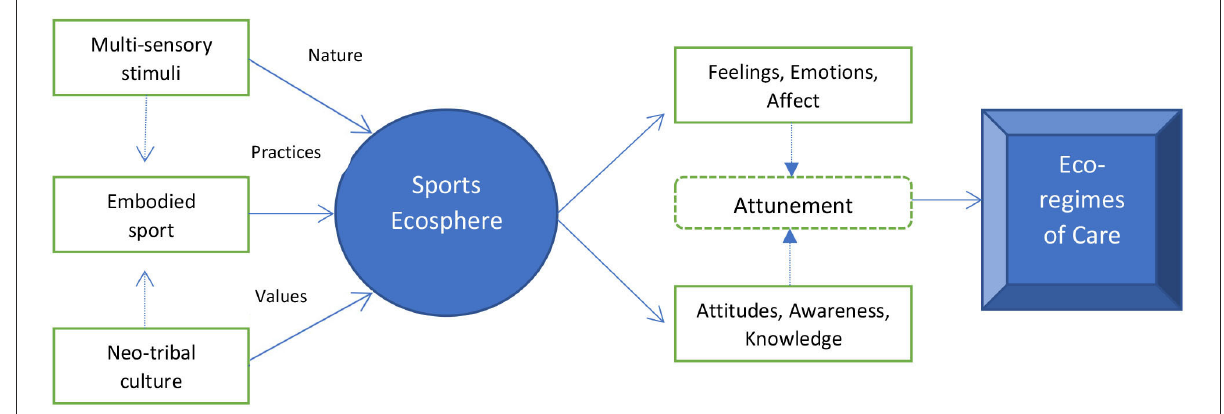
FIGURE1 Socio-ecological